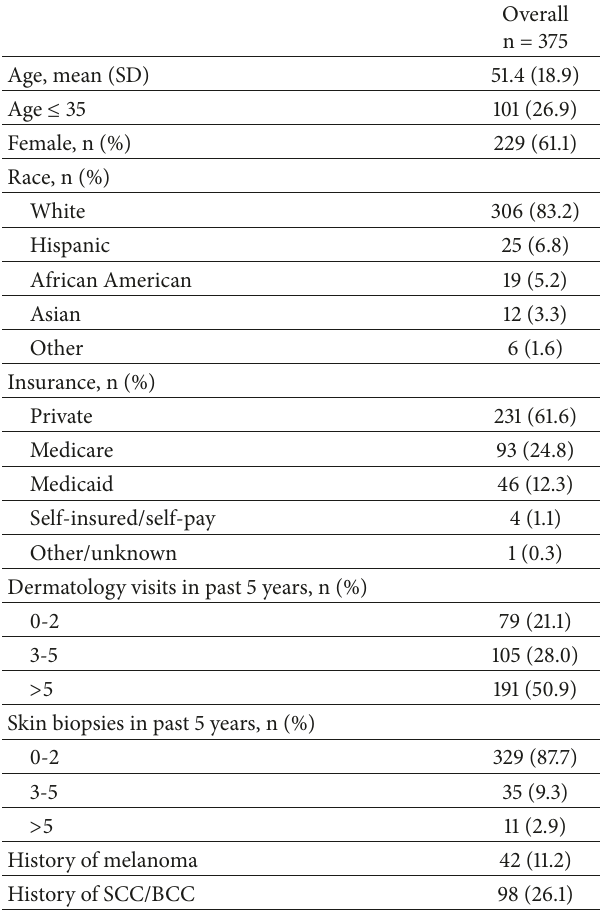
Table 1: Participant